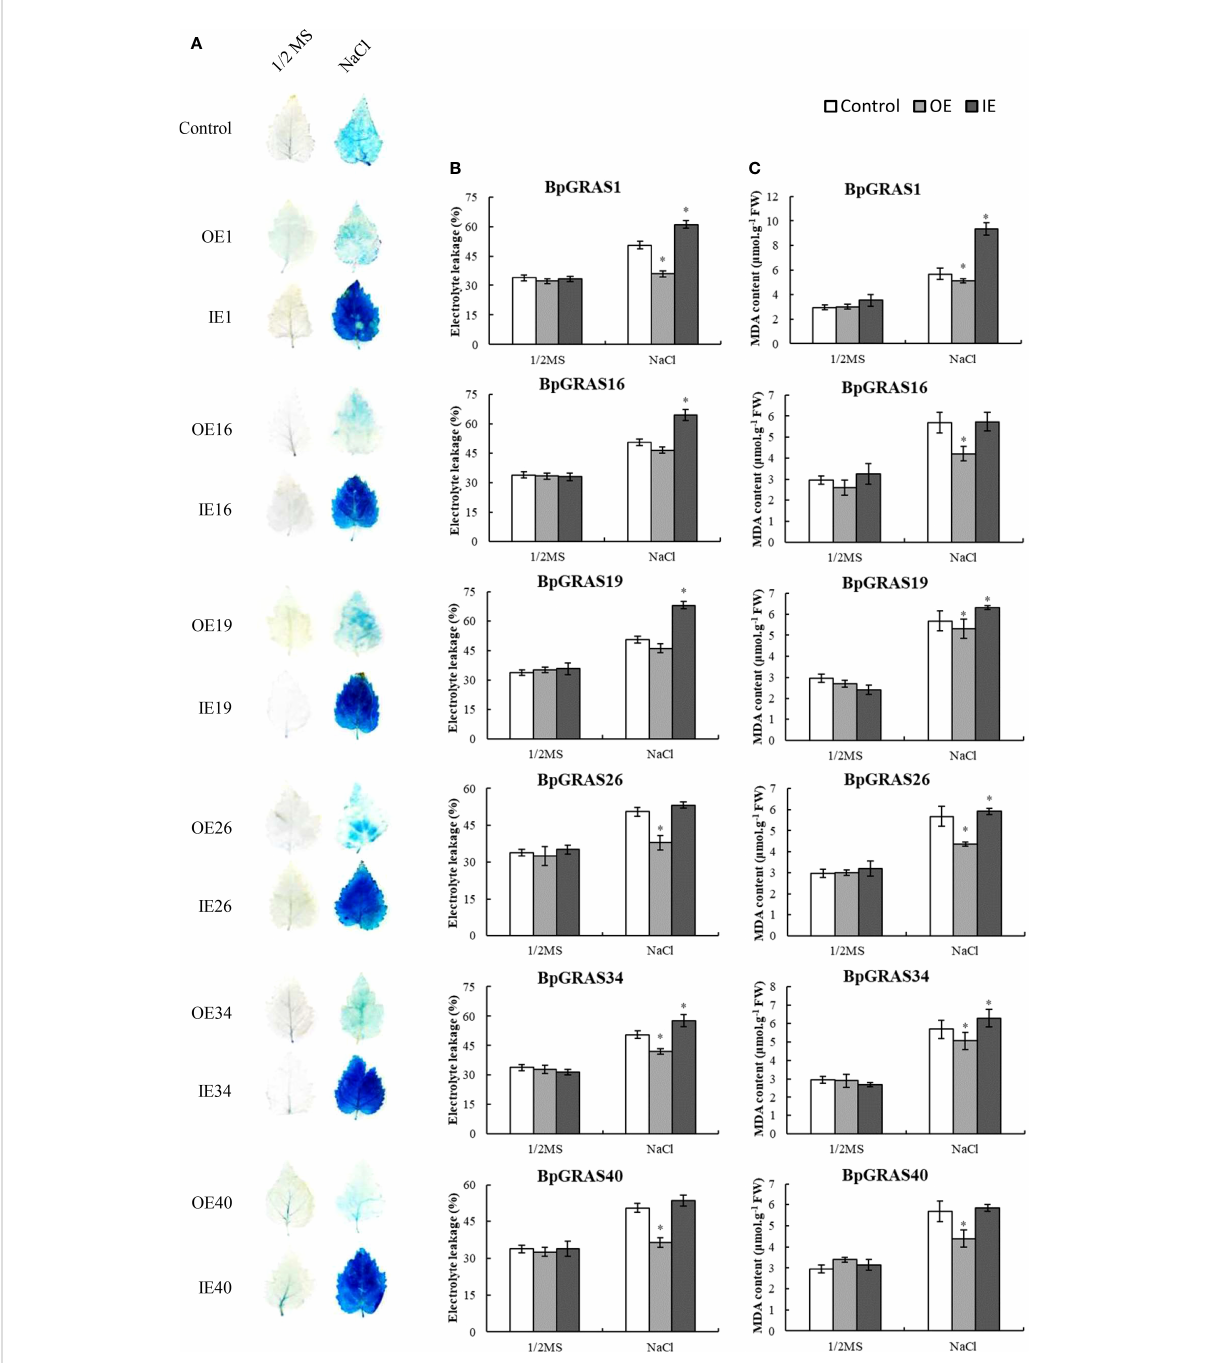
FIGURE 7 Detection of cell death, electrolyte leakages, and MDA contents in OE, IE, and control plants. (A) Birch plants treated with 150 mM NaCl and stained with Evens blue to visualize cell death. (B) Comparison of electrolyte leakage rates. (C) MDA contents. Data represents means ± SD values from three independent experiments. * signi fi cant (P< 0.05) difference was observed, compared to control plants. Control: birch plants transformed with empty pROKII; OE: birch plants exhibiting overexpression of BpGRAS ; IE: birch plants exhibiting inhibited expression of BpGRAS